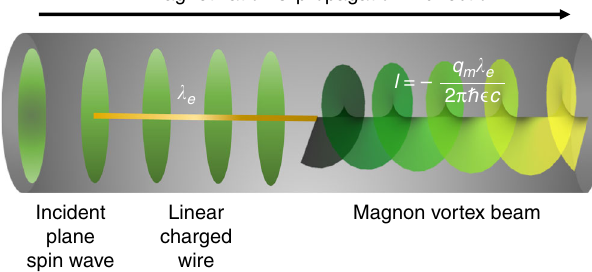
Fig. 1 Proposal for generating a twisted magnon beam exploiting the Aharanov – Casher effect. Incident spin waves (impinging from left) that propagate in a cylindrical magnetic insulator waveguide traverse a region with a linear charge density λ e (marked yellow). As demonstrated here, a magnonic twisted beam emerges to the right and can be quanti fi ed by the topological charge ‘ / λ , which is associated with a monopole-like vector e b e ð r Þ (cid:7) λ e potential, A ϕ that is intimately related to the Dirac phase for r e